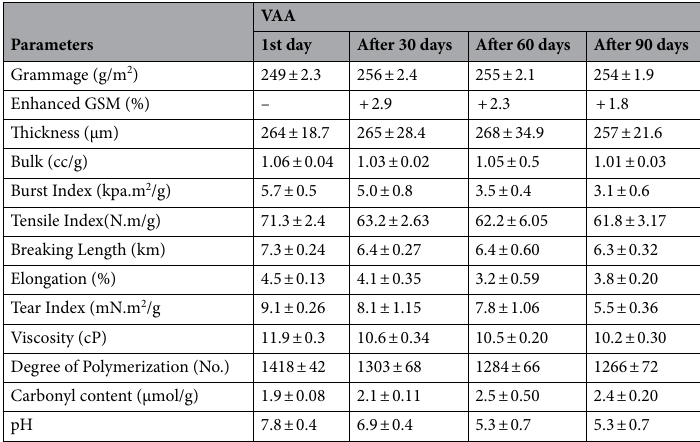
Table 2. Mechanical properties of unbleached pulp sheets exposed to Acetic acid.